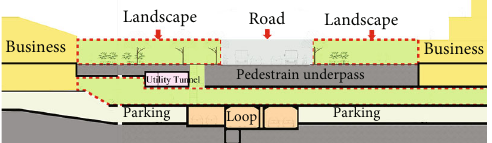
Figure 7: Development form of public resources of underground space (source: self-created per the relevant